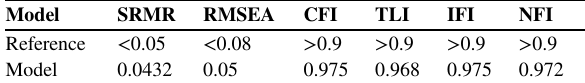
Table 4 The fi t of the structural equation model